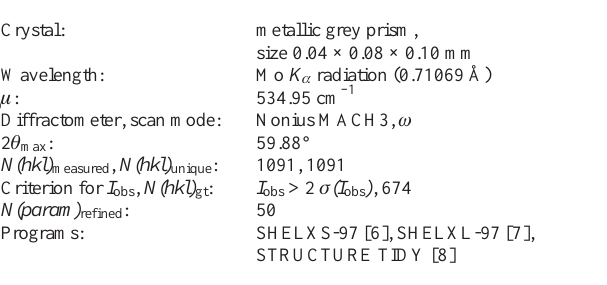
Table 1. Data collection and